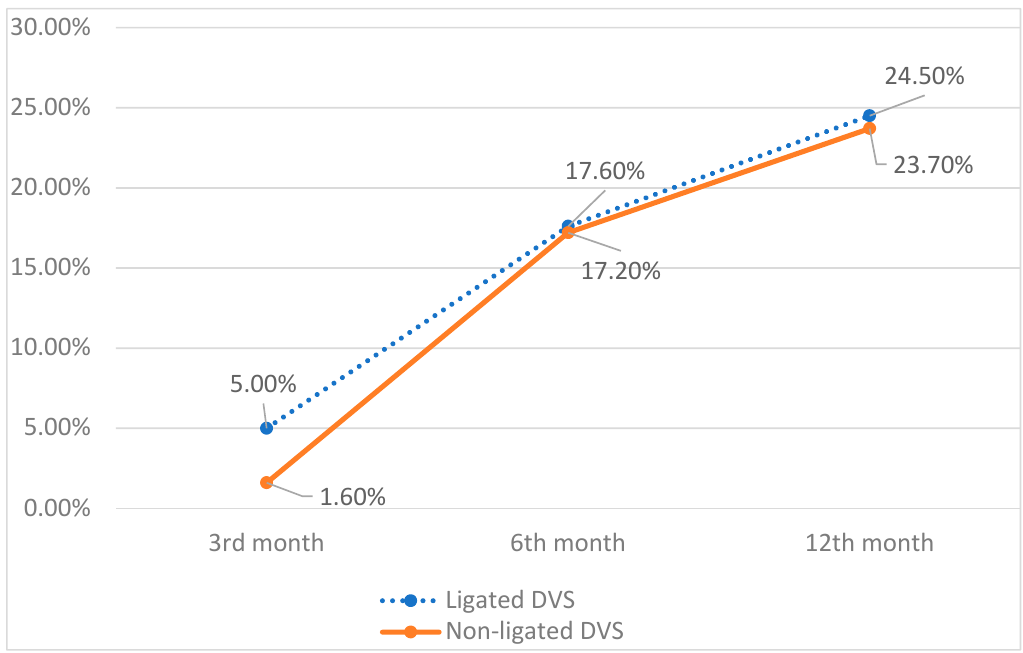
Figure 2. Erectile function recovery in 12 months follow up.